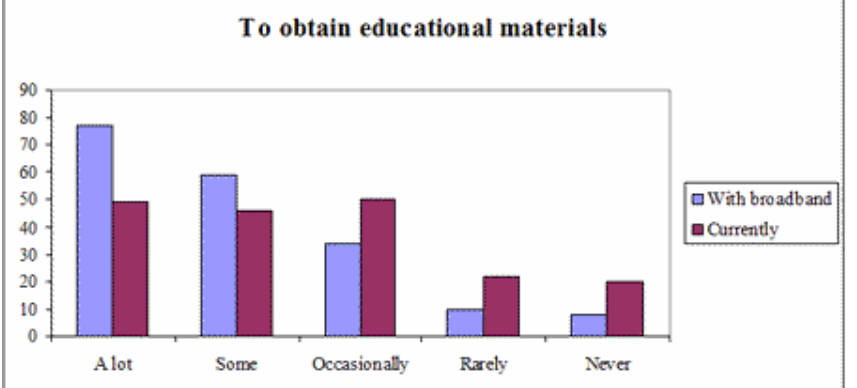
Figure 5. Respondents’ Current and Anticipated Use of the Internet to Obtain Educational Materials